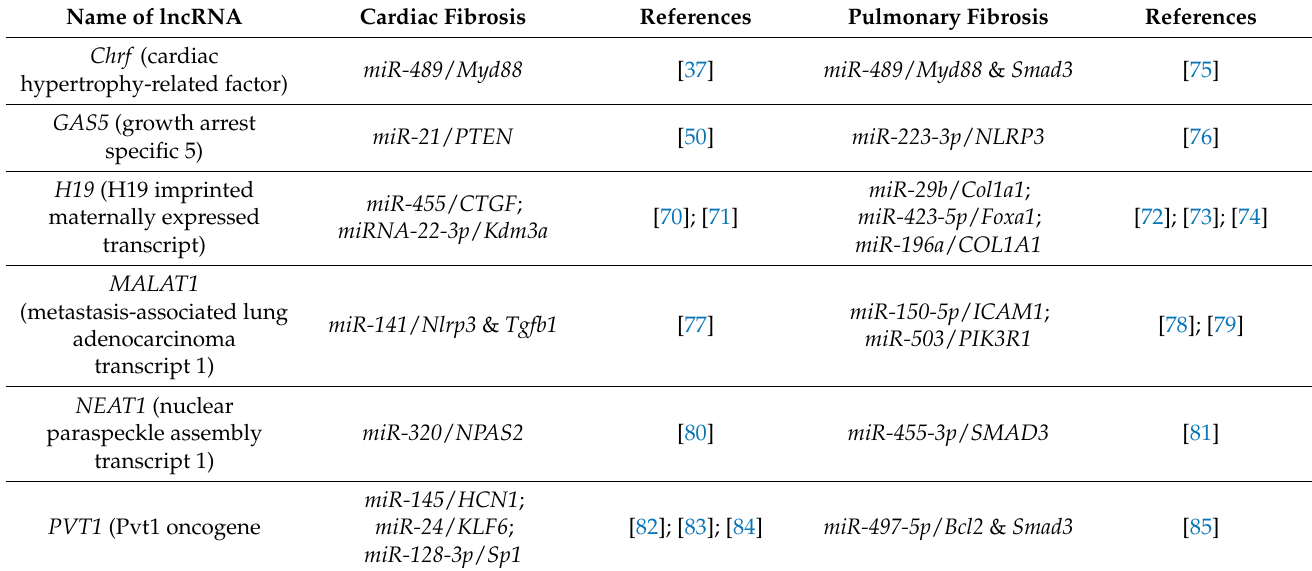
Table 3. List of cardiac and pulmonary fibrotic lncRNAs functioning as miRNA sponges: In the Cardiac Fibrosis and Pulmonary Fibrosis columns, miRNAs and their target mRNAs are shown, which are separated by a forward slash. When there are multiple entries (i.e., miRNA/target mRNA) for each column, each entry is separated by a semicolon. This applies to the corresponding references as